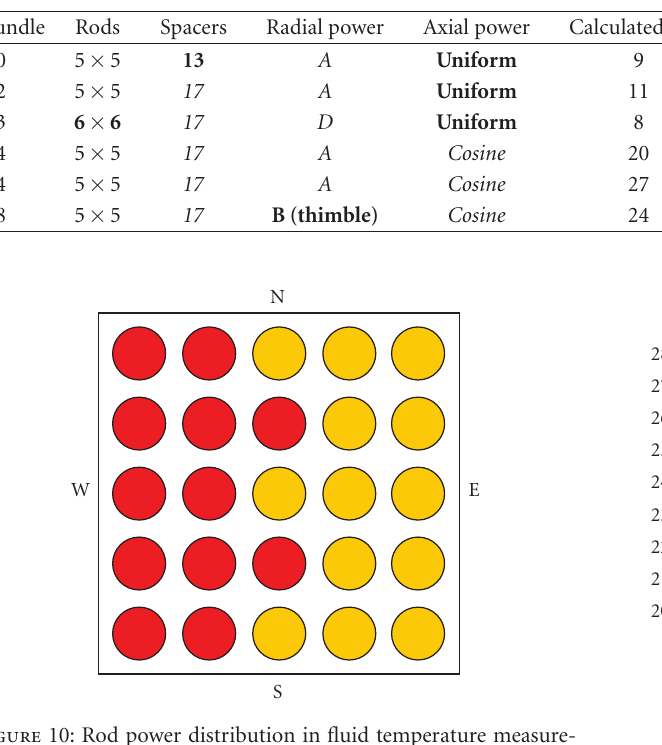
Table 4: Results of 6 series of DNB simulations in rod bundles.